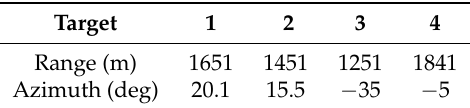
Table 2. Estimated values of the locations for four